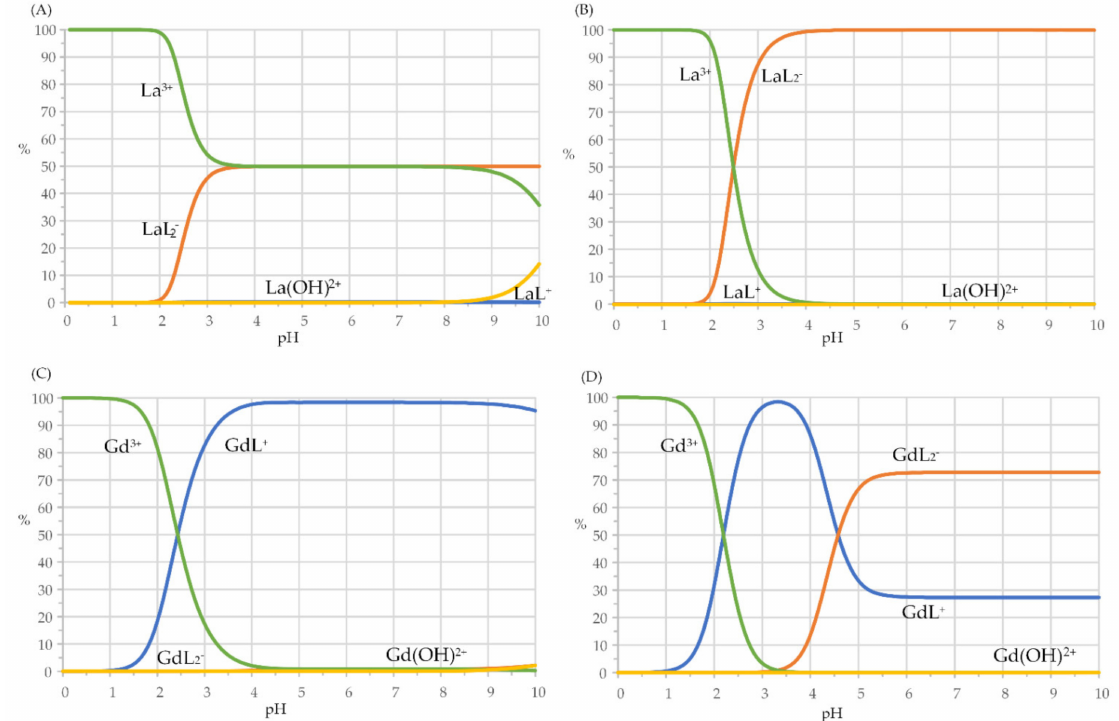
Figure 5. Distribution diagrams for: La 3+ –harzianic acid and Gd 3+ –harzianic acid systems: ( A , C ) equal total concentrations (10 − 4 M) of harzianic acid and metal cations; ( B , D ) harzianic acid total concentration (2 × 10 − 4 M) twice the total concentration of metal